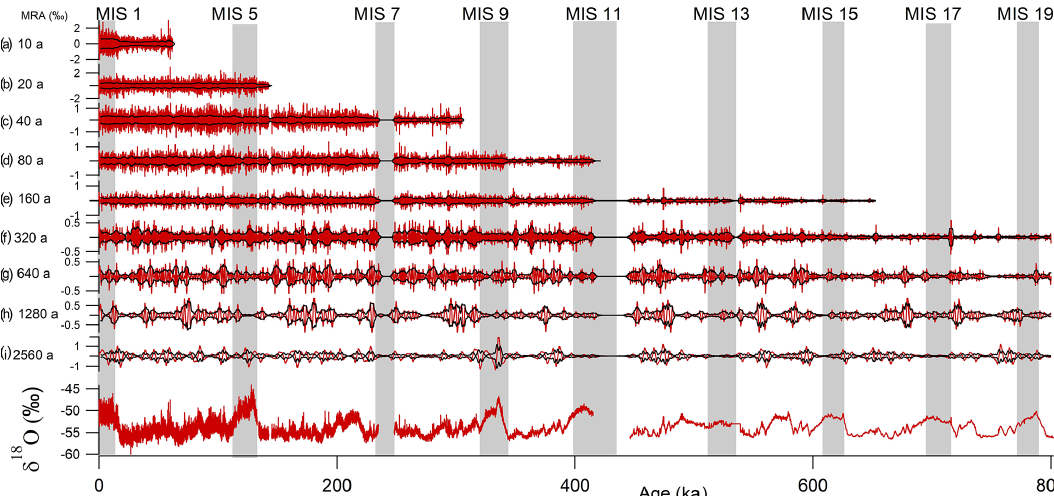
Figure 4. Contributions to the original δ 18 O signal (red) of the MRA composites with resolutions of 10 (a) , 20 (b) , 40 (c) , 80 (d) , 160 (e) , 320 (f) , 640 (g) , 1280 (h) and 2560 years (i) . Marine Isotope Stage intervals are marked as grey bars. The black envelope presents the running standard deviation (1 σ ) in 3kyr windows.